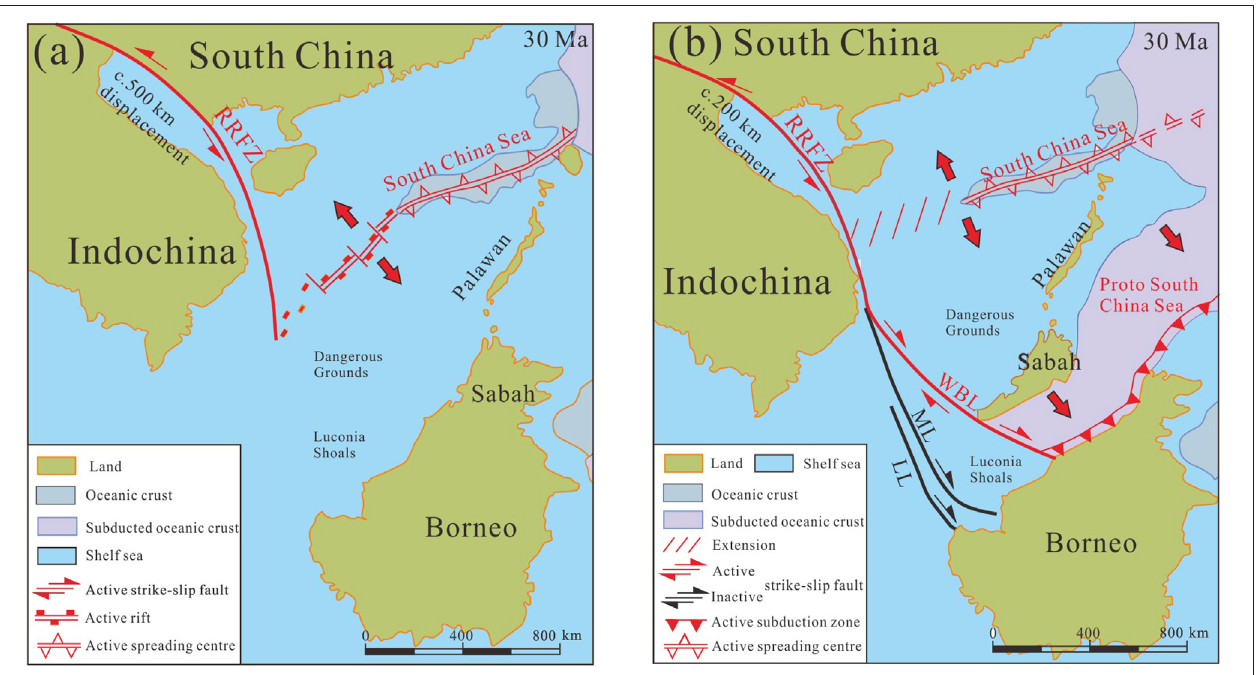
FIGURE 2 | Two potential models for the opening of the South China Sea (modi fi ed after Mazur et al., 2012): (A) the pull-apart model and (B) the slab-pull model. LL, Lupar Line; ML, Mersing Line, RRFZ, Red River Fault Zone, WBL, West Baram Line.